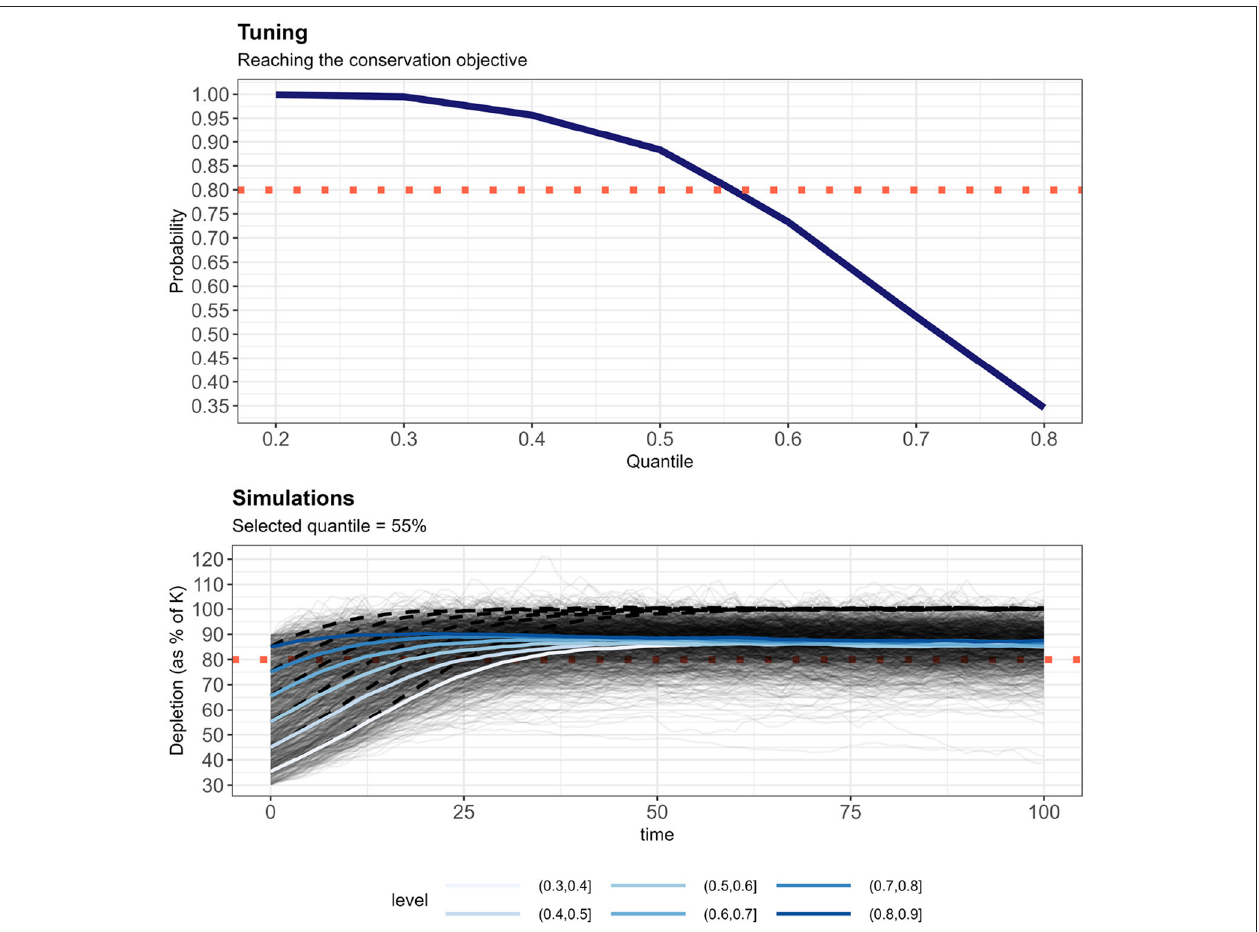
FIGURE 5 | Top panel: Probability to reach the conservation objective (CO) for setting the removals limit as a quantile of the posterior distribution of Equation (2). The 55th quantile is the largest one that allows reaching the CO with a probability of 0.8 after 100 years. Lower panel: All 1,200 simulations (thick lines: average stratified by initial depletion level) after the implementation of the RLA and removals limit set by using the 55th quantile. The red dotted line shows the 80% of carrying capacity ( K ). The black hashed line shows average population trajectory if anthropogenic removals were eliminated.